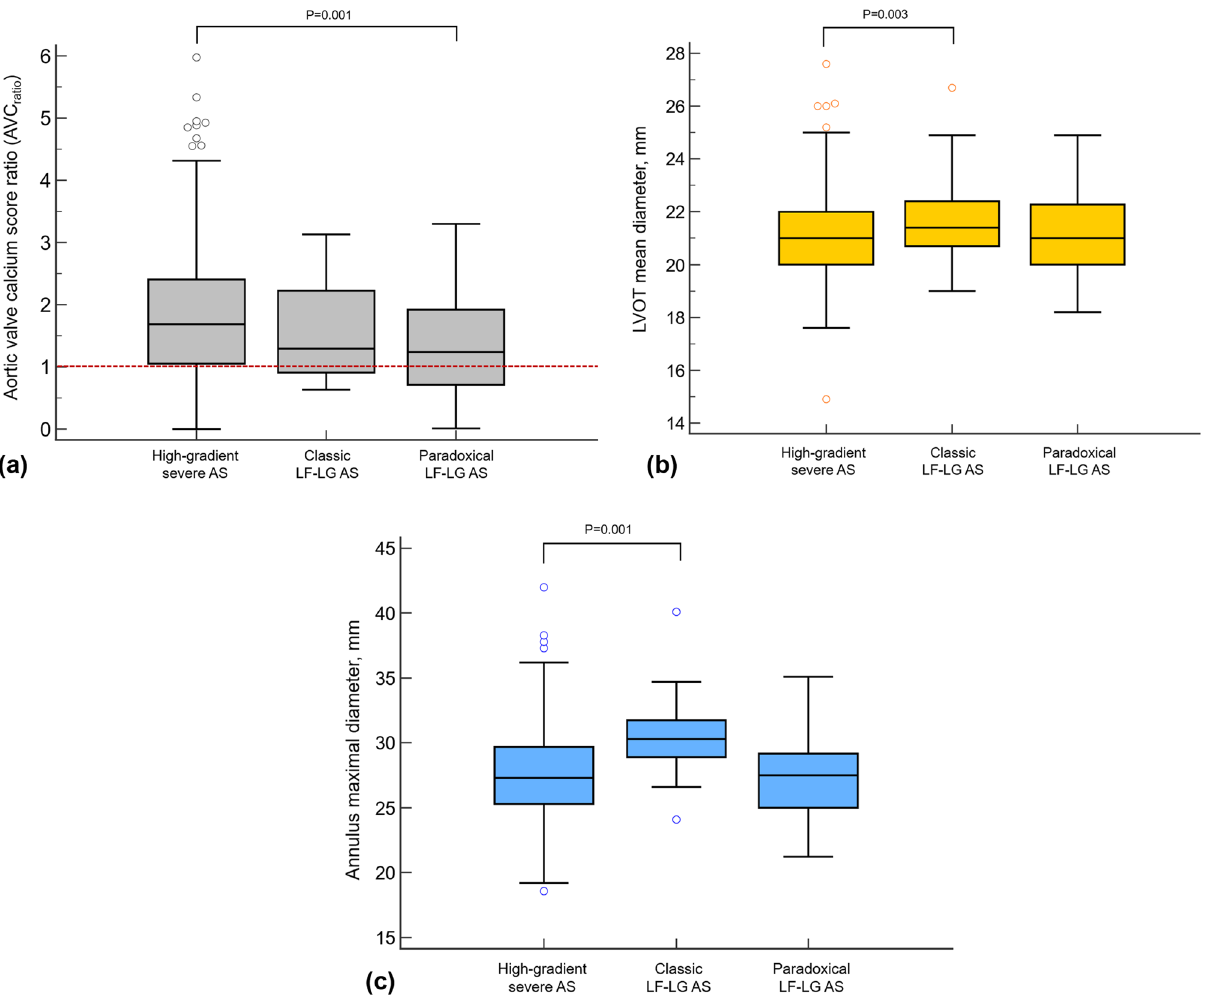
Figure 3. Box plot to demonstrate the distribution of AVC ratio , LVOT mean diameter, and maximal diameter of aortic annulus according to subtypes. ( a ) AVC ratio was calculated by dividing AVC with sex-specific thresholds (Male, 2000; Female, 1250). The score above the red-dotted line represents AVC above the sex-specific threshold, and consequently, severe aortic stenosis. The score below the red-dotted line represents the AVC below the sex-specific threshold and nonsevere calcification. The mean of AVC ratio was significantly lower in paradoxical LF-LG AS than that of high gradient severe AS (P = 0.001). In addition, the proportion of nonsevere calcification was most frequent in paradoxical LF-LG AS patients. Both ( b ) LVOT mean diameter and ( c ) maximal diameter of aortic annulus were lowest in LF-LG AS patients among the three subtypes and significantly larger than